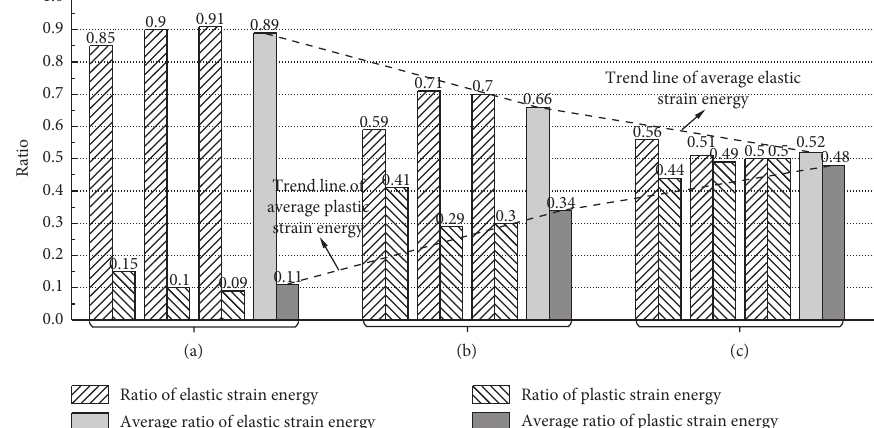
Figure 11: Ratio of elastic energy and dissipation energy during loading and unloading. (a) Coal samples without gas. (b) Coal samples with 1MPa gas pressure. (c) Coal samples with 2MPa gas